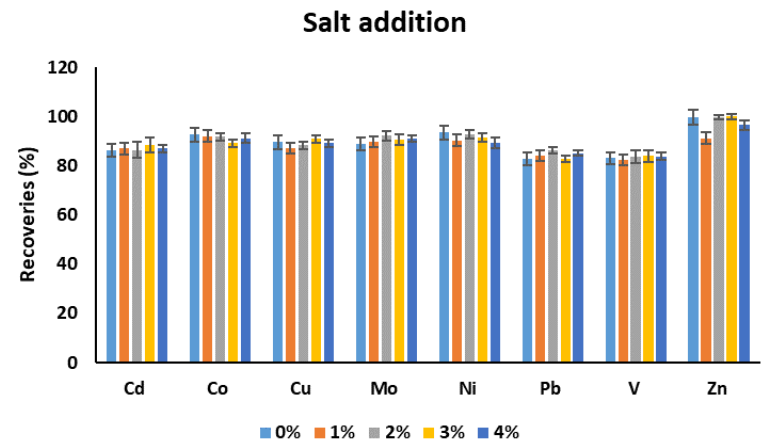
Figure 7. The effect of salt addition on the recoveries of target metals. Experimental conditions: sample pH: 4.5, volume of complexing reagent: 200 µL, volume of extraction solvent: 7.5 mL, extraction solvent: chloroform, extraction time: 10 min.